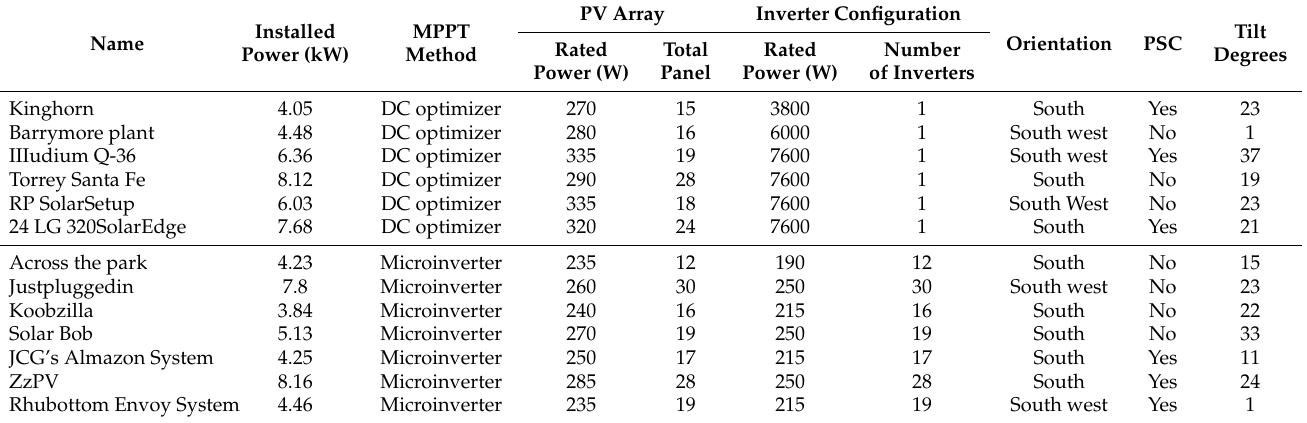
Table 1. PV stations located in Kinghorn, San Diego, CA, USA (postcode: 92129) used in our study of the energy utilization ratio. The chosen stations share the same postcode (within 4 km). Thus, they are assumed to suffer similar weather conditions. Partial shading decreases temporarily the amount of radiation reaching the solar